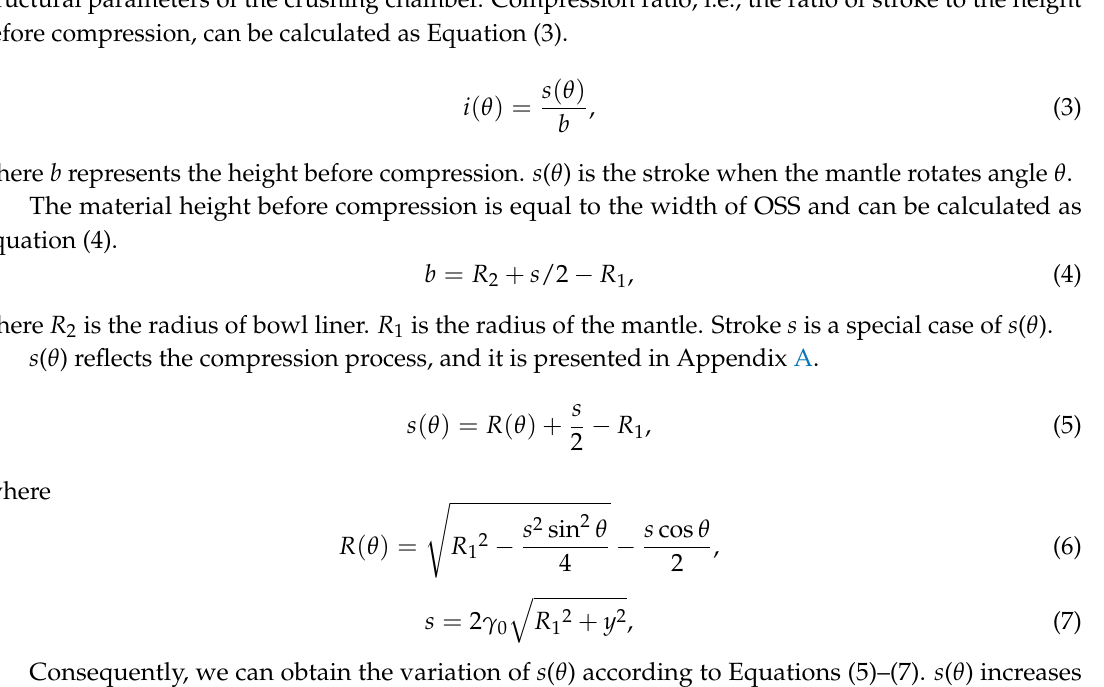
Figure 2. The variation of s ( θ ).